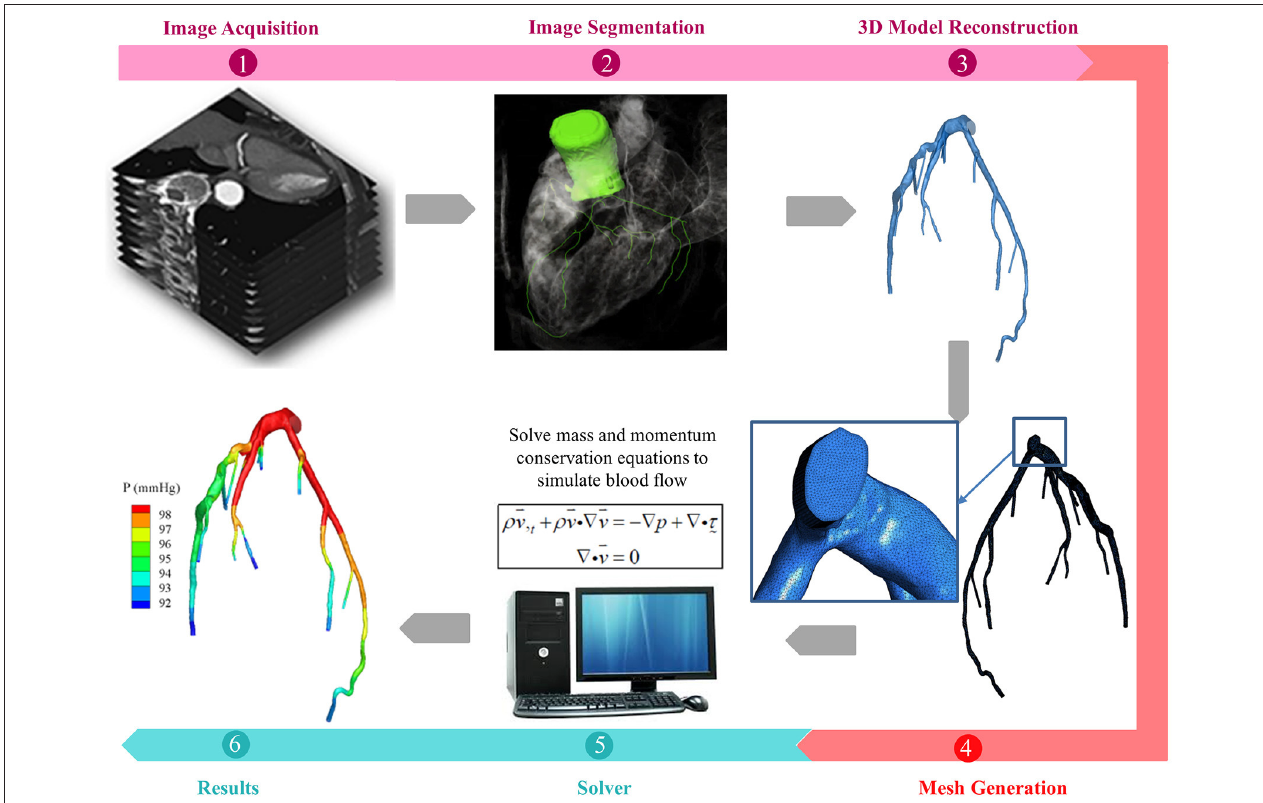
FIGURE 1 | Schematic drawings for the procedures of patient-specific simulations for blood flow in coronary arteries, including (1) acquisition of CTA or ICA images (2) segmentation of acquired images (3) reconstruction of 3D model (4) mesh generation to discretize the 3D model (5) solving the mass and momentum conservation equations to simulate the blood flow in coronary arteries, if FSI is taken into consideration, solid solver will also be activated, and (6) presentation of